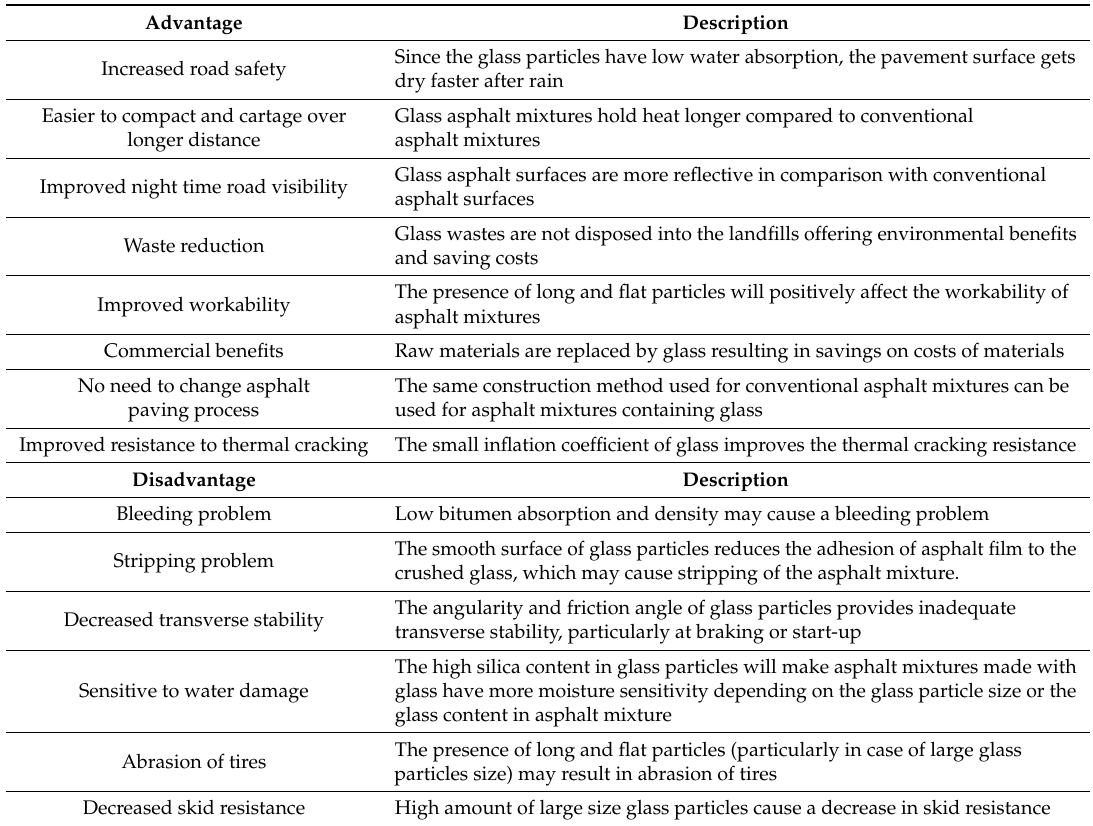
Table 1. Advantages and disadvantages of utilization of glass in asphalt